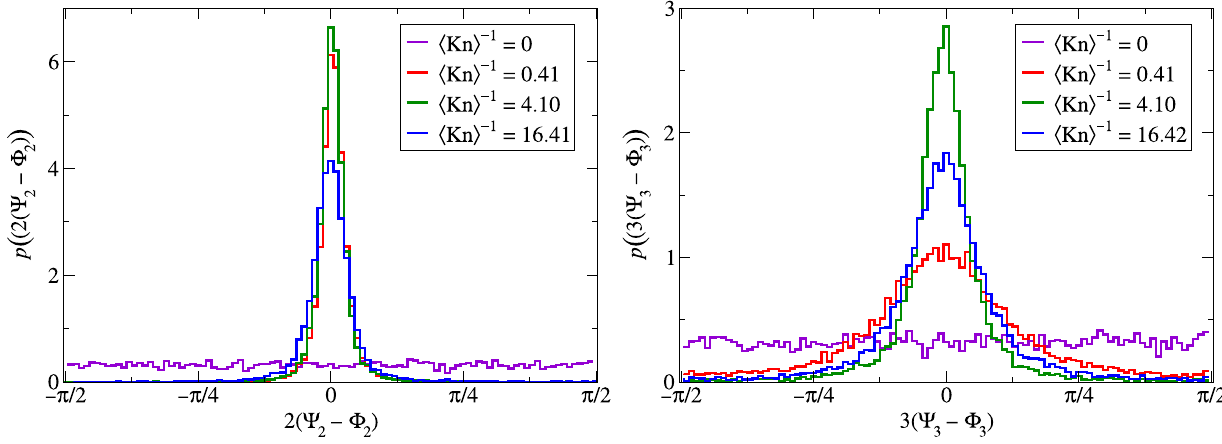
Fig. 12 Probability distribution of p ( 2 ((cid:5) 2 − (cid:4) 2 )) (left) and p ( 3 ((cid:5) 3 − (cid:4) 3 )) (right) at b = 9 fm for different values of (cid:3) Kn (cid:4) −